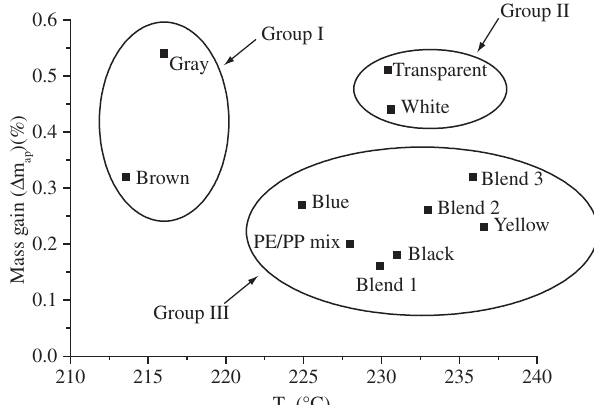
Figure 2. Typical polyolefin thermogravimetric curves in synthetic air and in ni- trogen from ambient temperature to 350 °C, with mass-loss scale expanded. Figure 3. Chart of ∆ m